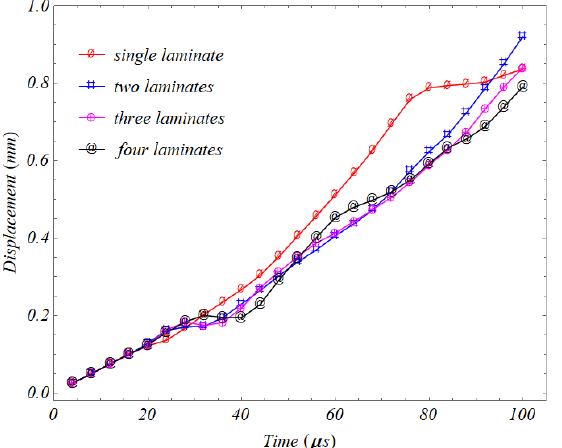
Fig. 28. Displacement against time for various number of cellphone casing laminates at 2000mm drop